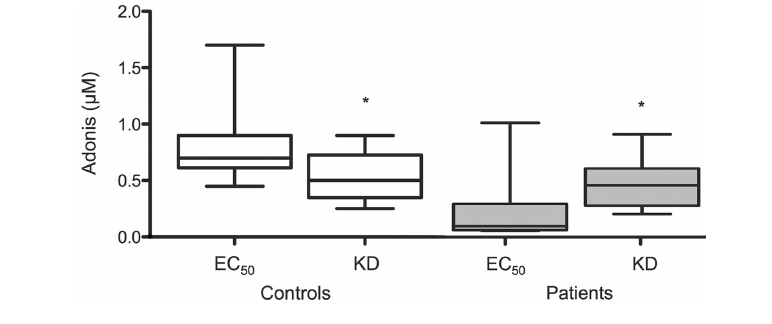
/K ratio. Comparison of EC 50 D